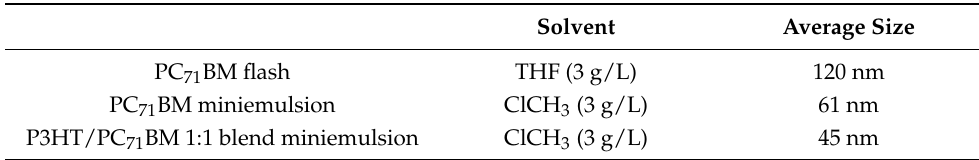
Figure 5. Morphology of particles deposited onto silicon wafers. ( a ) PC 71 BM nanoparticles prepared by flash technique; ( b ) PC 71 BM nanoparticles prepared by miniemulsion; ( c ) nanoparticles of a 1:1 blend of P3HT and PC 71 BM prepared by miniemulsion. Table 2. Characteristic parameters of the size distribution of PC 71 BM and PC 71 BM/P3HT blend nanoparticles prepared under different